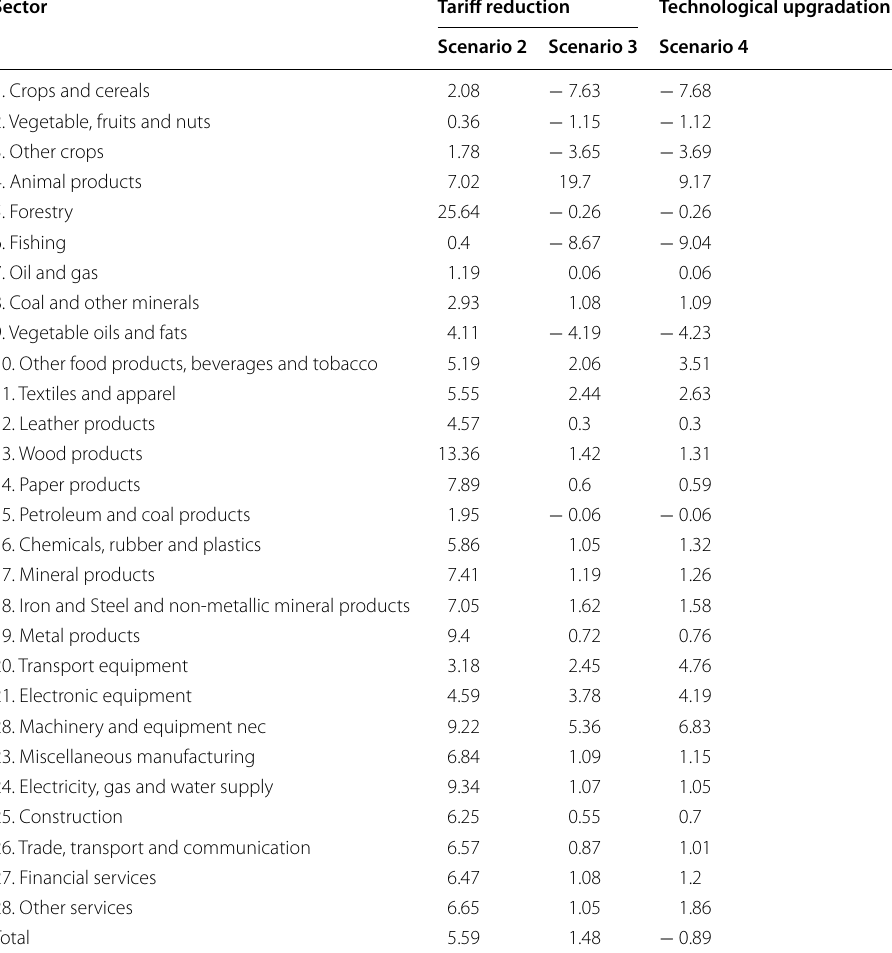
Table 7 Sectoral import growth due to tariff simulation and technological upgradation at 2030 compared to BAU 2030 (without USA as TPP member) Sector